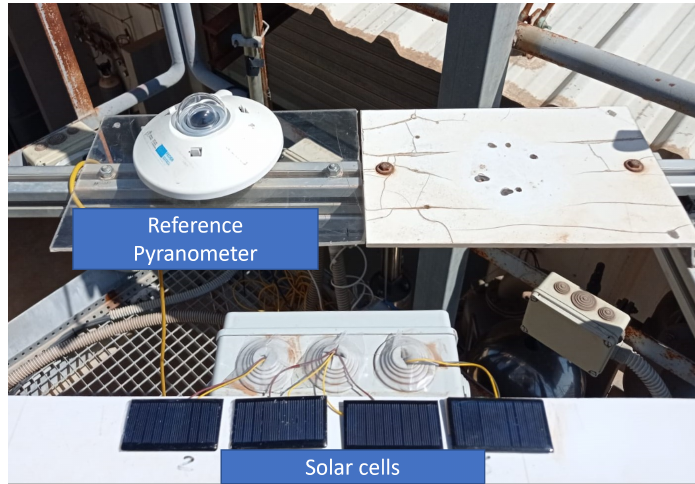
Figure 6. Solar panel calibration:lLaboratory